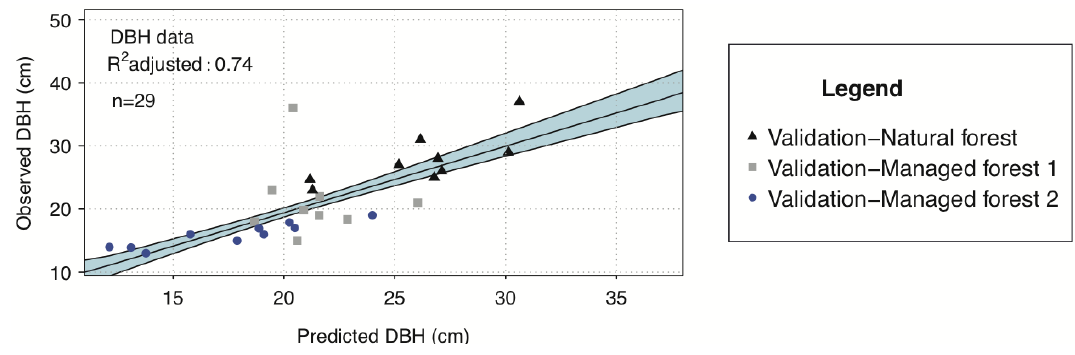
Figure 8. Predicted versus observed forest mean DBH values (validation dataset). Each point represents one field plot. The light blue polygon shows the area of 95% confidence interval and black solid line represents the regression